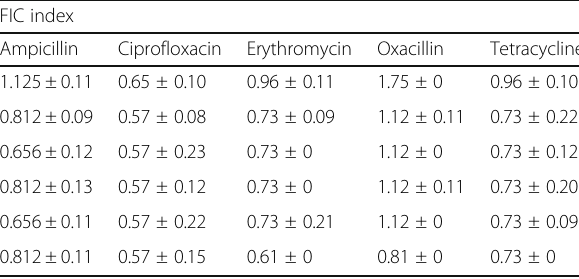
Table 3 FIC index of the tested antibiotic FIC